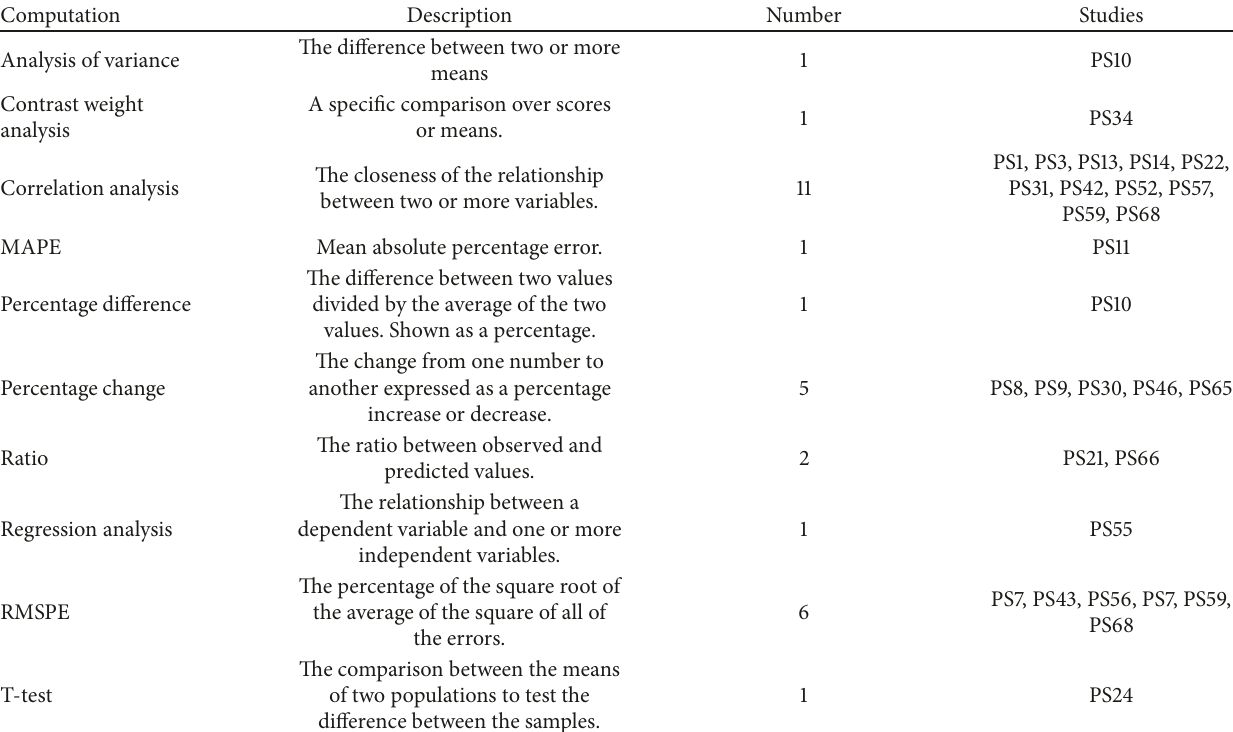
Table 11: Summary of statistics used to evaluate the performance of predicted versus observed